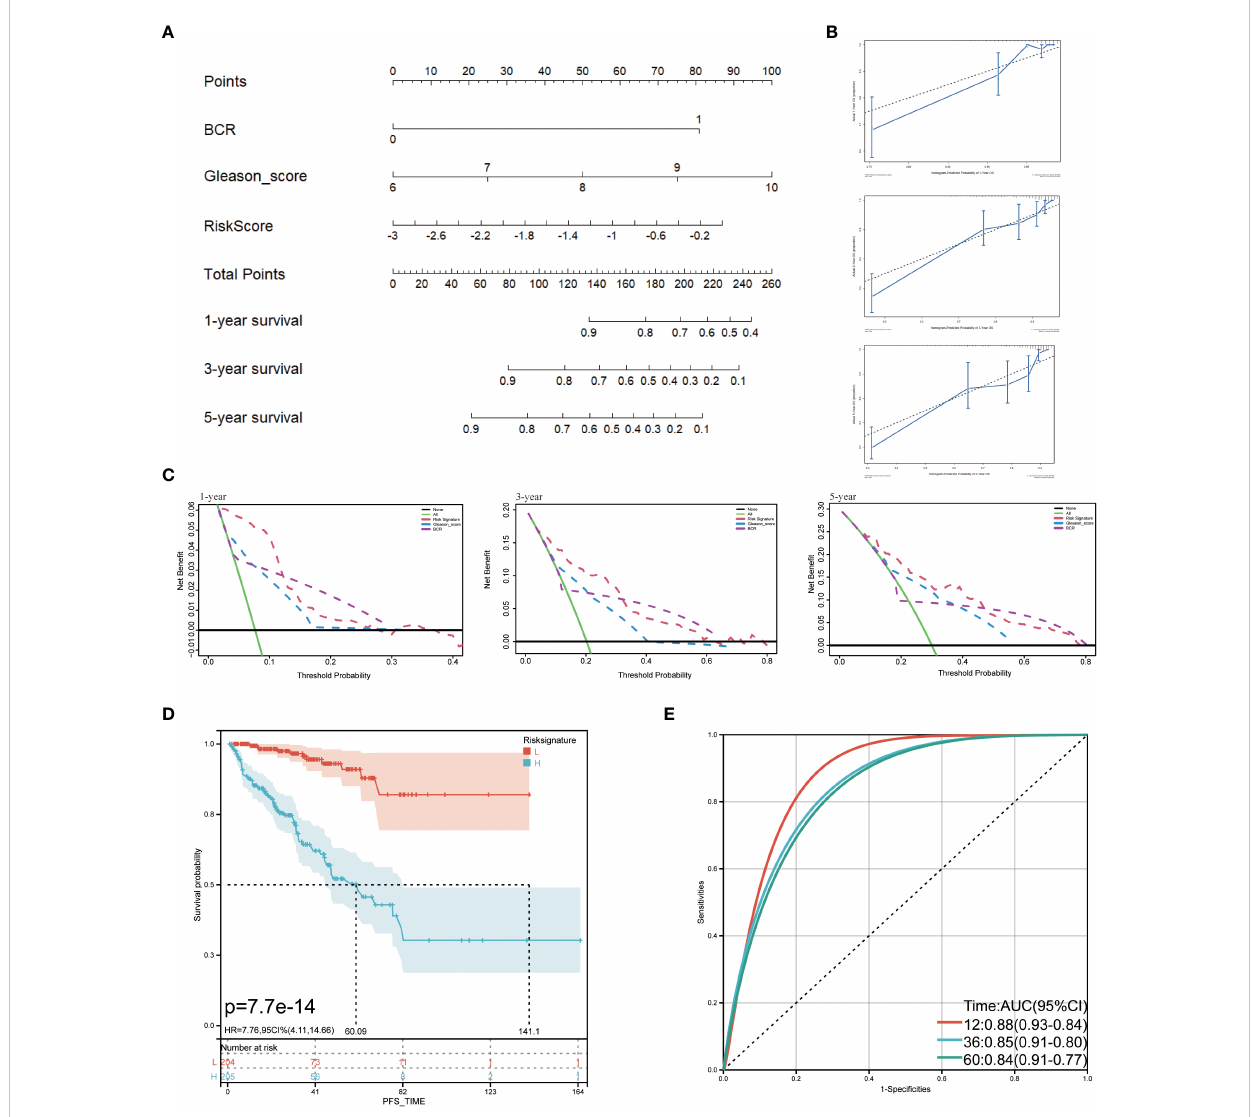
FIGURE 8 Predictive value of prognostic risk score combined with clinical/immune characteristics for PFS in patients with TCGA cohort. (A) Nomogram for predicting PFS of patients in TCGA cohort; (B) The calibration diagram of the nomogram. The X axis is the survival rate predicted by the nomogram, and the Y axis is the actual survival rate; (C) Analysis of decision curve of nomogram; (D) Survival curve of low-signature and high-signature; (E) Time-dependent ROC